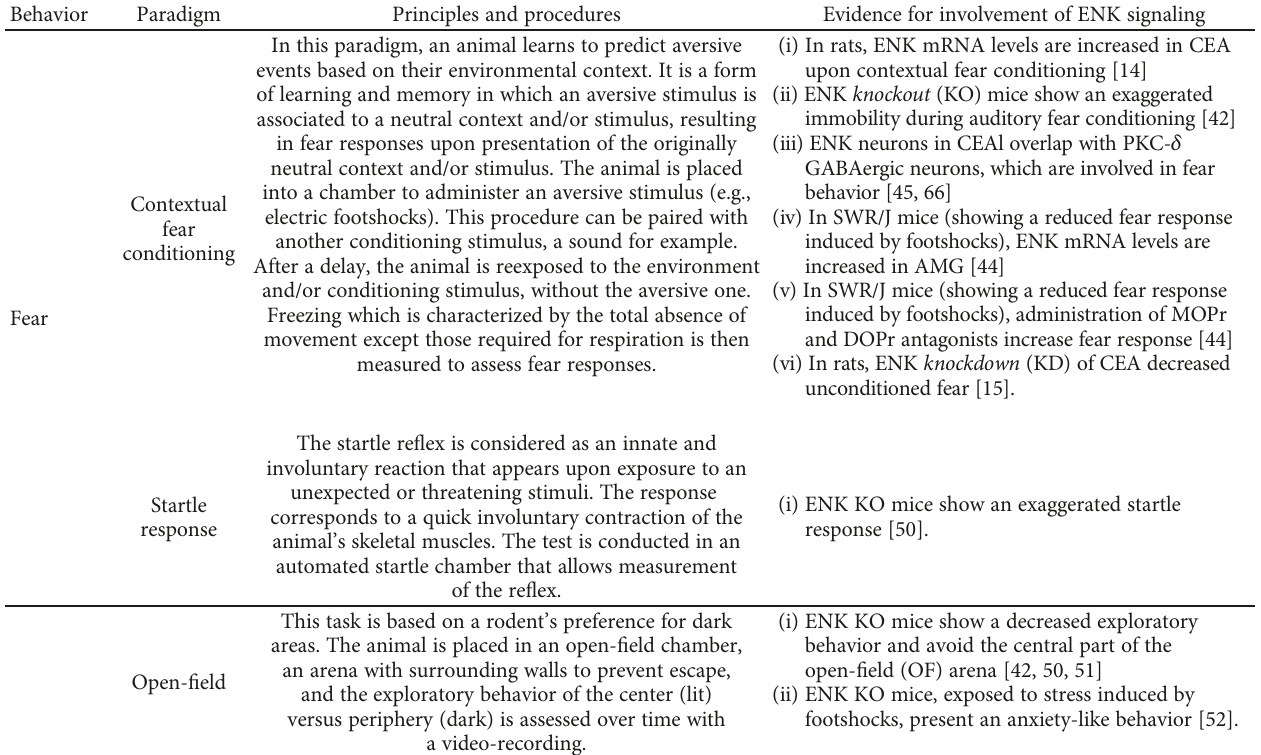
Table 1: Evidence for ENK signaling involvement using di ff erent behavioral